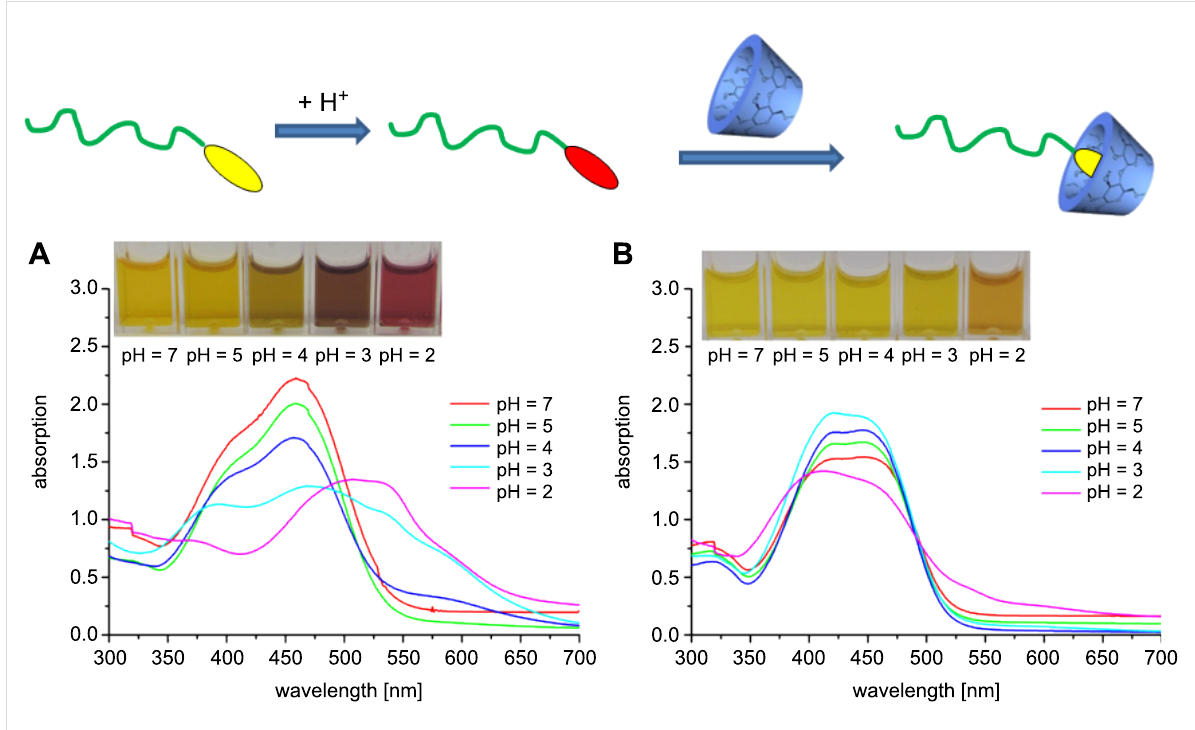
Figure 1: Absorption spectra of 6 in water in a pH range from 7 to 2 (A). Absorption spectra of 6 in water depending on the pH in the presence of RAMEB-CD